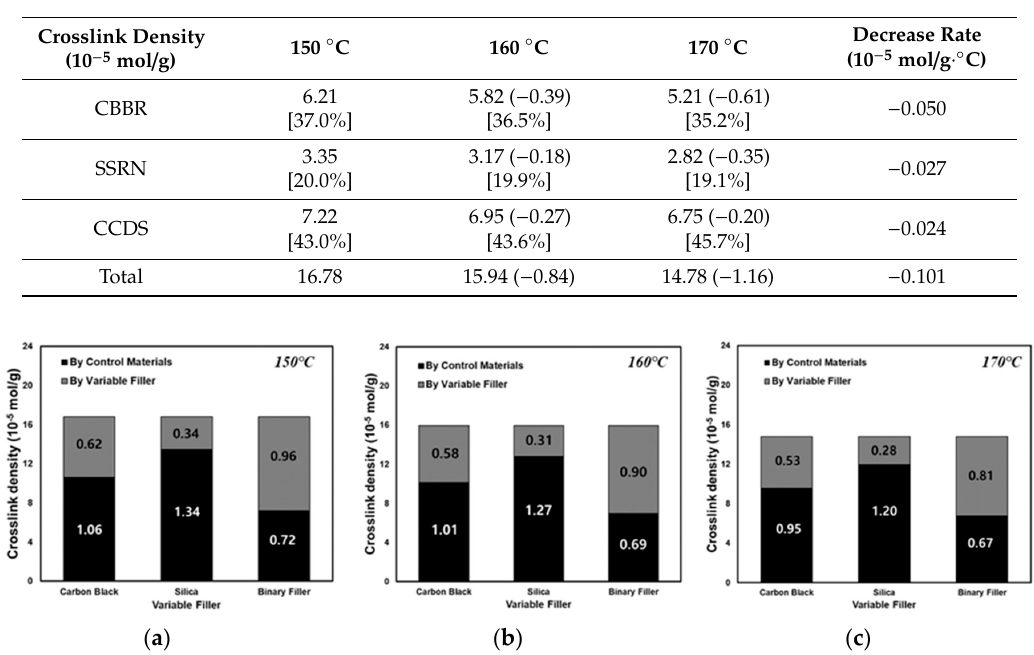
Figure 5. Analysis of the vulcanizate structures of the T-3 compound according to filler variates at different cure temperatures of ( a ) 150, ( b ) 160, and ( c ) 170 °C. Table 4. Vulcanizate structure of the SBR binary compound (T-3) at different cure temperatures.